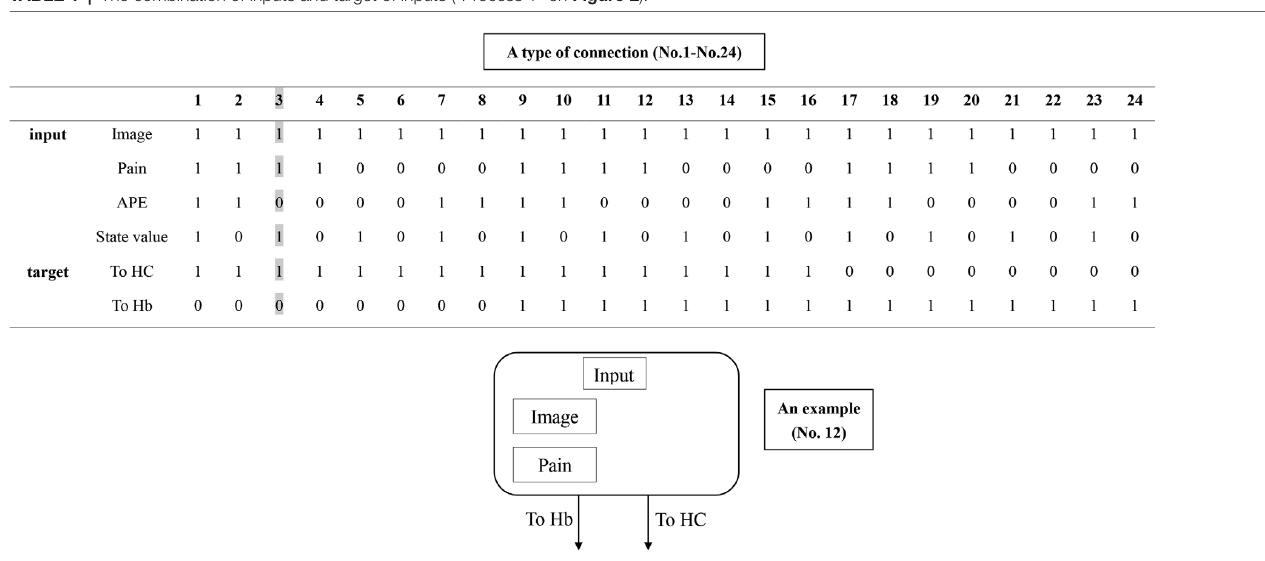
TABLE 1 | The combination of inputs and target of inputs (“Process 1” on Figure 2 ).